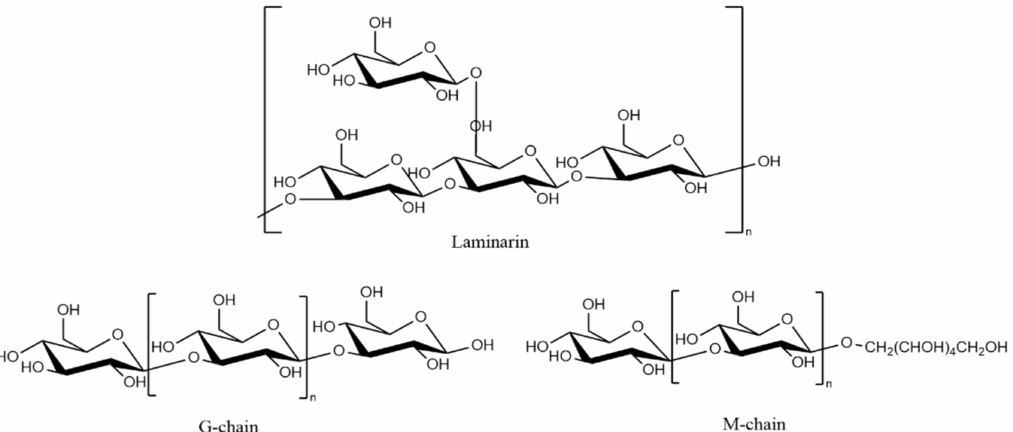
Figure 8. Chemical structure of laminarin fragments and two types of chains.